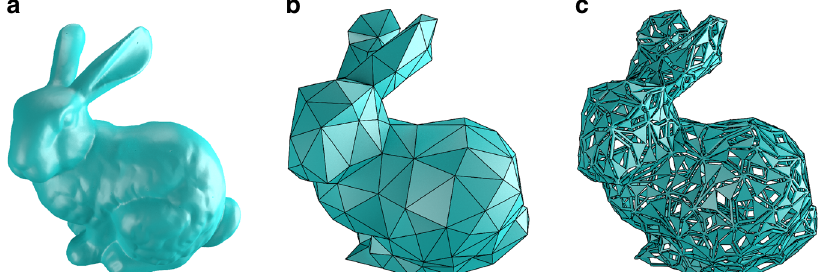
Fig. 10 Dilation of the Stanford bunny. a shows the original Stanford bunny 32 . b shows our adaptation of the triangulated version by Thingiverse user johnny6 33 , which was used to create the dilational surface shown in c by replacing each triangular face with skew pantograph mechanisms. The resulting surface has a scaling factor of λ ¼ 0 : 966. A movie of the fi nal mechanism is included in the supplementary material